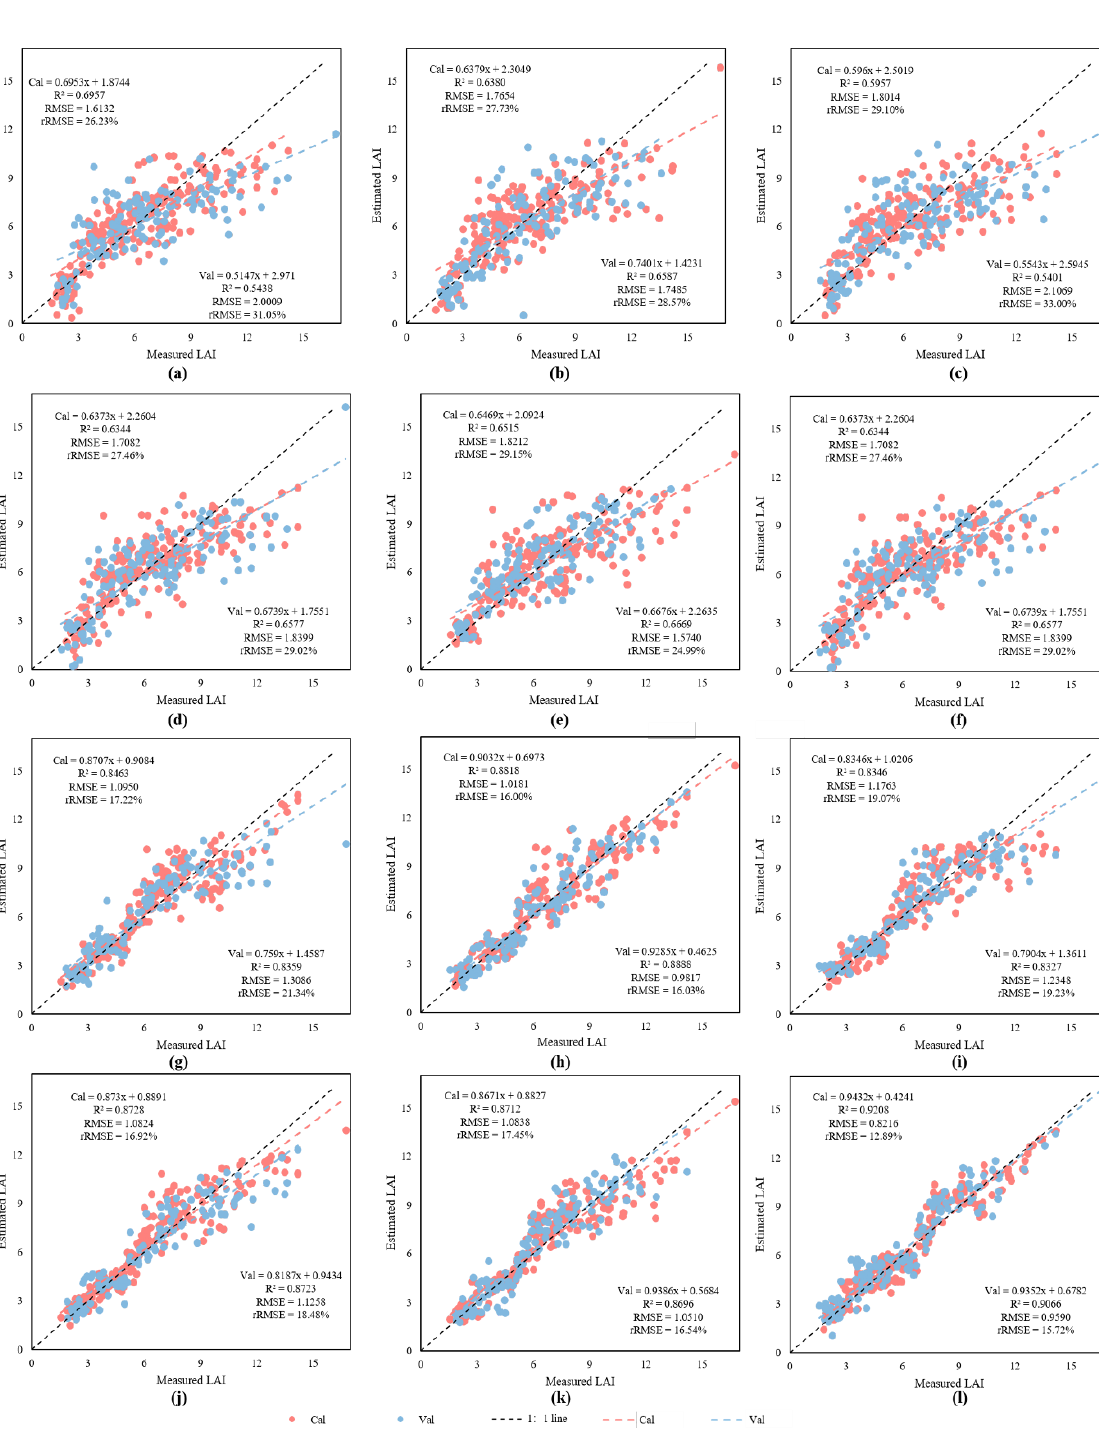
Figure 12. Linear results of training sets (Cal) and validation sets (Val) measured and predicted values based on spectral reflectance and vegetation indices: ( a ) MSR-SNV-SPA-MSC-VIs, ( b ) MSR-SNV- SPA-SG-VIs, ( c ) MSR-SNV-SPA-SNV-VIs, ( d ) MSR-SNV-SFLA-MSC-VIs, ( e ) MSR-SNV-SFLA-SG-VIs, ( f ) MSR-SNV-SFLA-SNV-VIs, ( g ) ELM-SNV-SPA-MSC-VIs, ( h ) ELM-SNV-SPA-SG-VIs, ( i ) ELM-SNV-SPA-SNV-VIs, ( j ) ELM-SNV-SFLA-MSC-VIs, ( k ) ELM-SNV-SFLA-SG-VIs, and ( l ) ELM- SNV-SFLA-SNV-VIs.